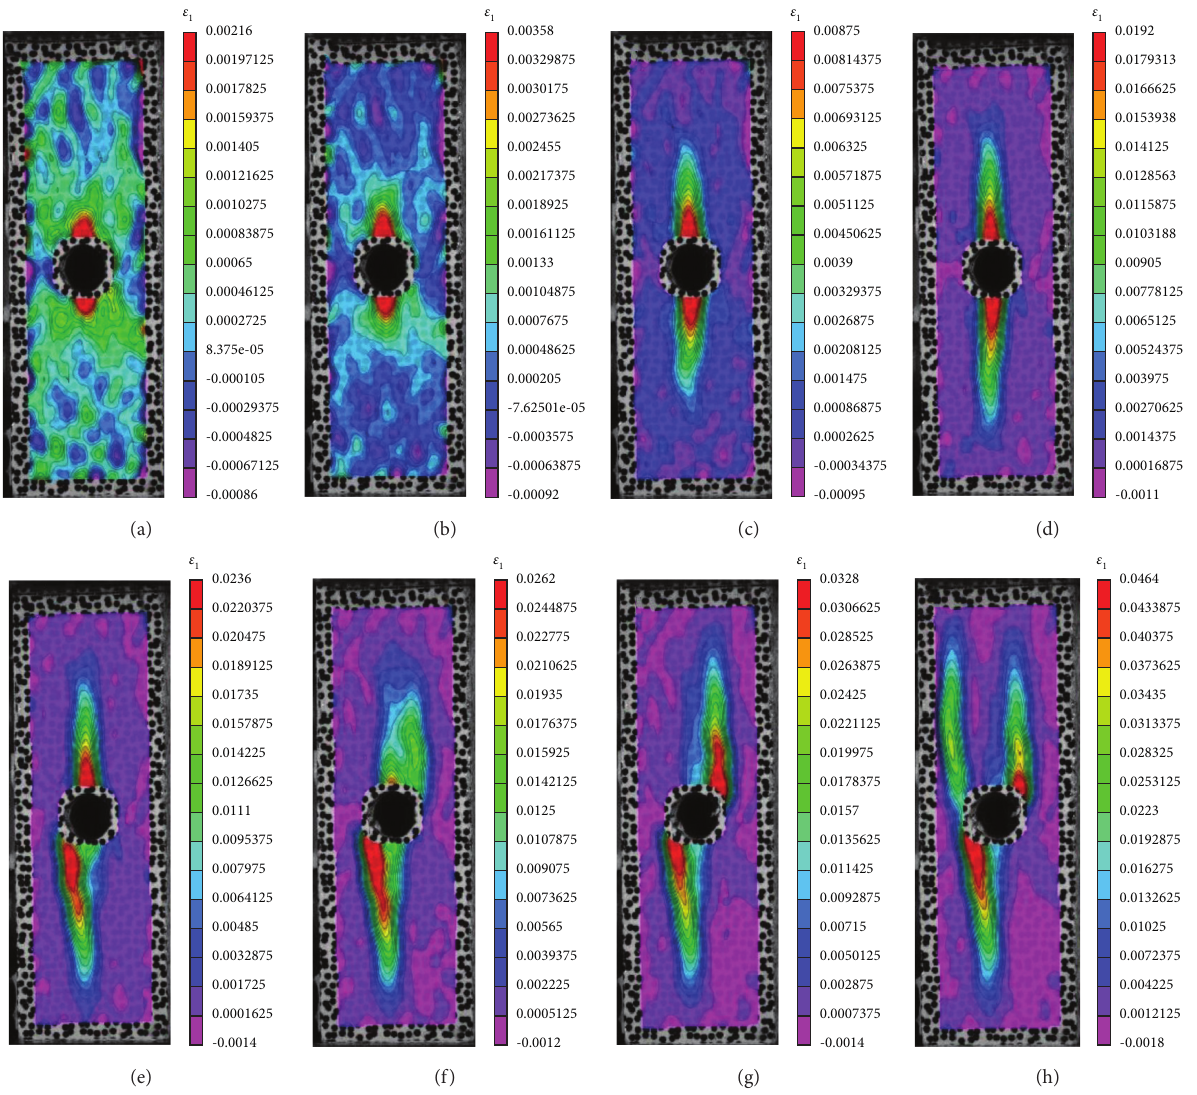
Figure 15: Nephogram of the major principal strain field at different stress levels corresponding to points A–H in Figure